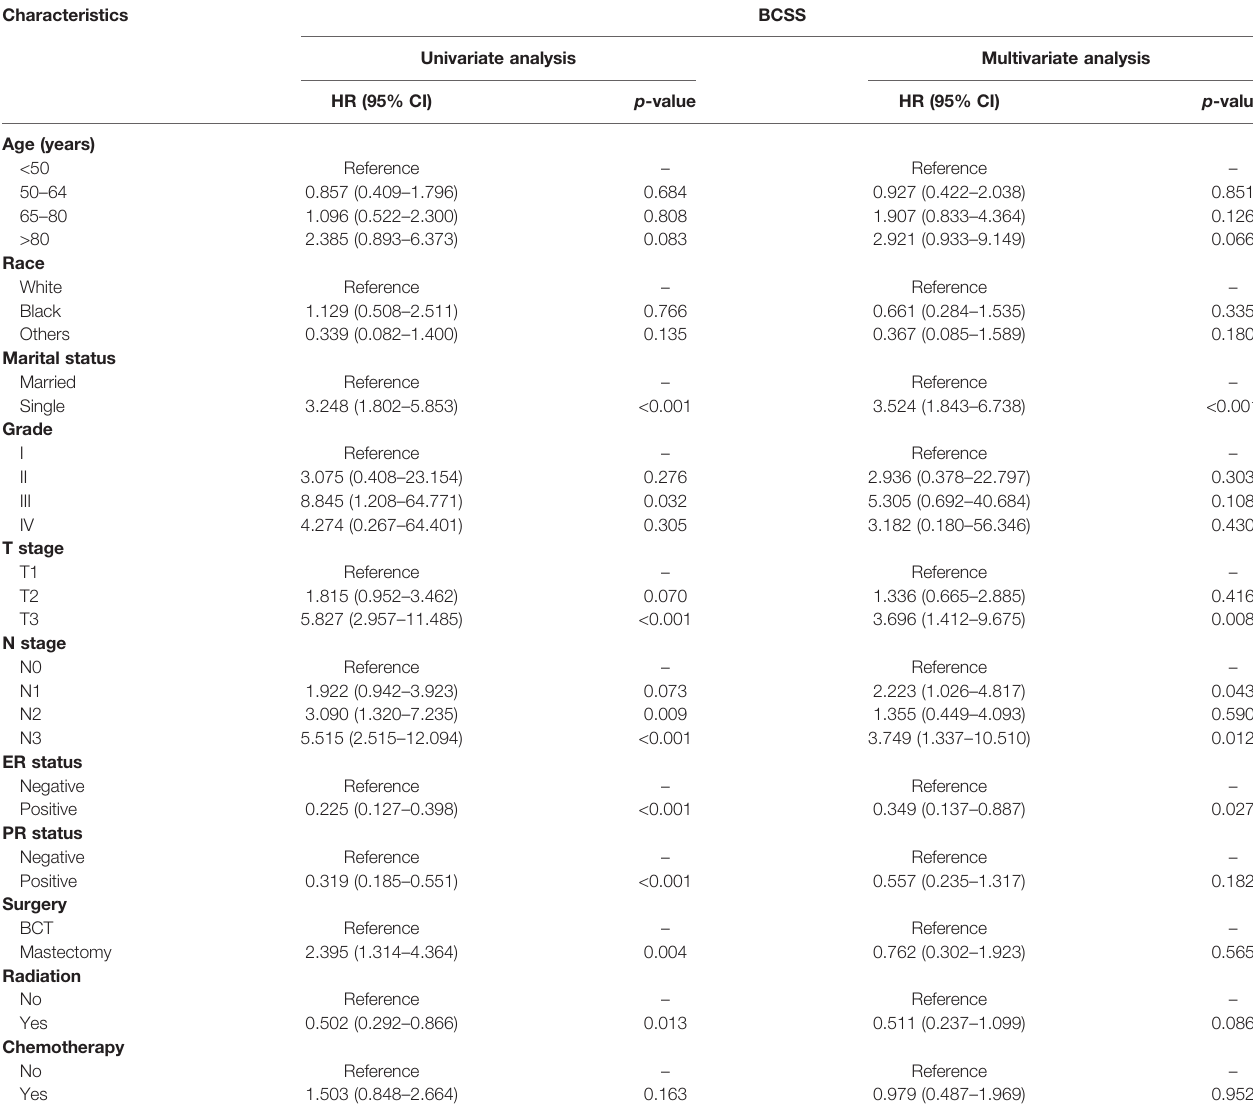
TABLE 3 | Univariate and multivariate analyses of BCSS of patients with early-stage IMPC.